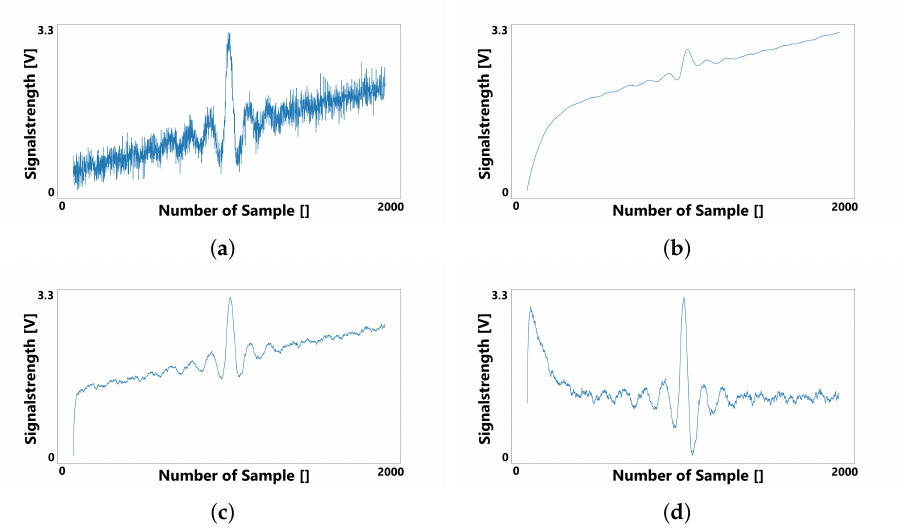
Figure 4. Smoothing a signal with two exponential moving averages: ( a ) depicts the original signal, while ( b ) (follow-factor s = 0.99) and ( c ) ( s = 0.9) present two moving averages with different following factors applied to the original signal. Subtracting these results in the preprocessed signal shown in ( d ).